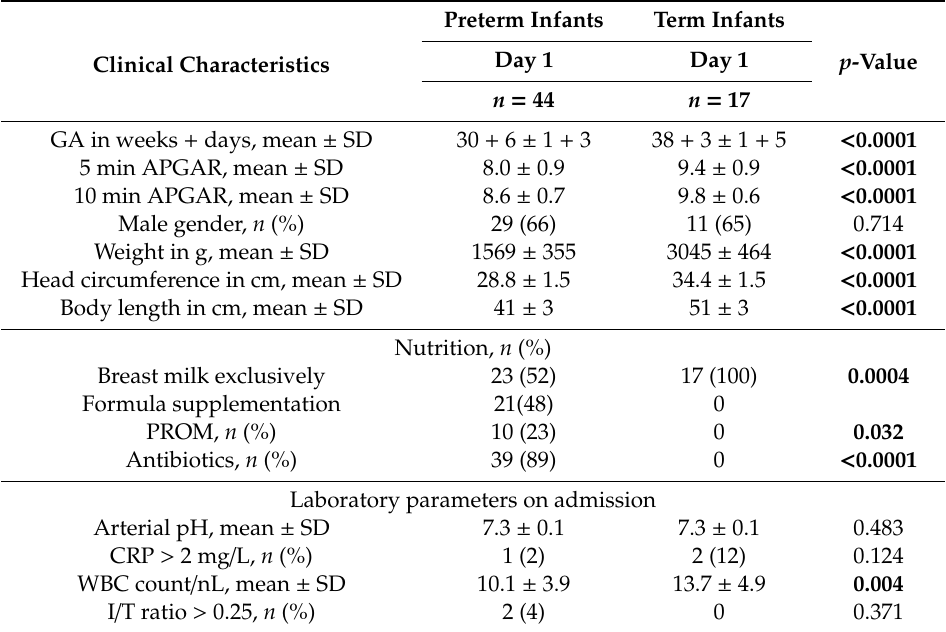
Table 1. Basic and clinical characteristics of study